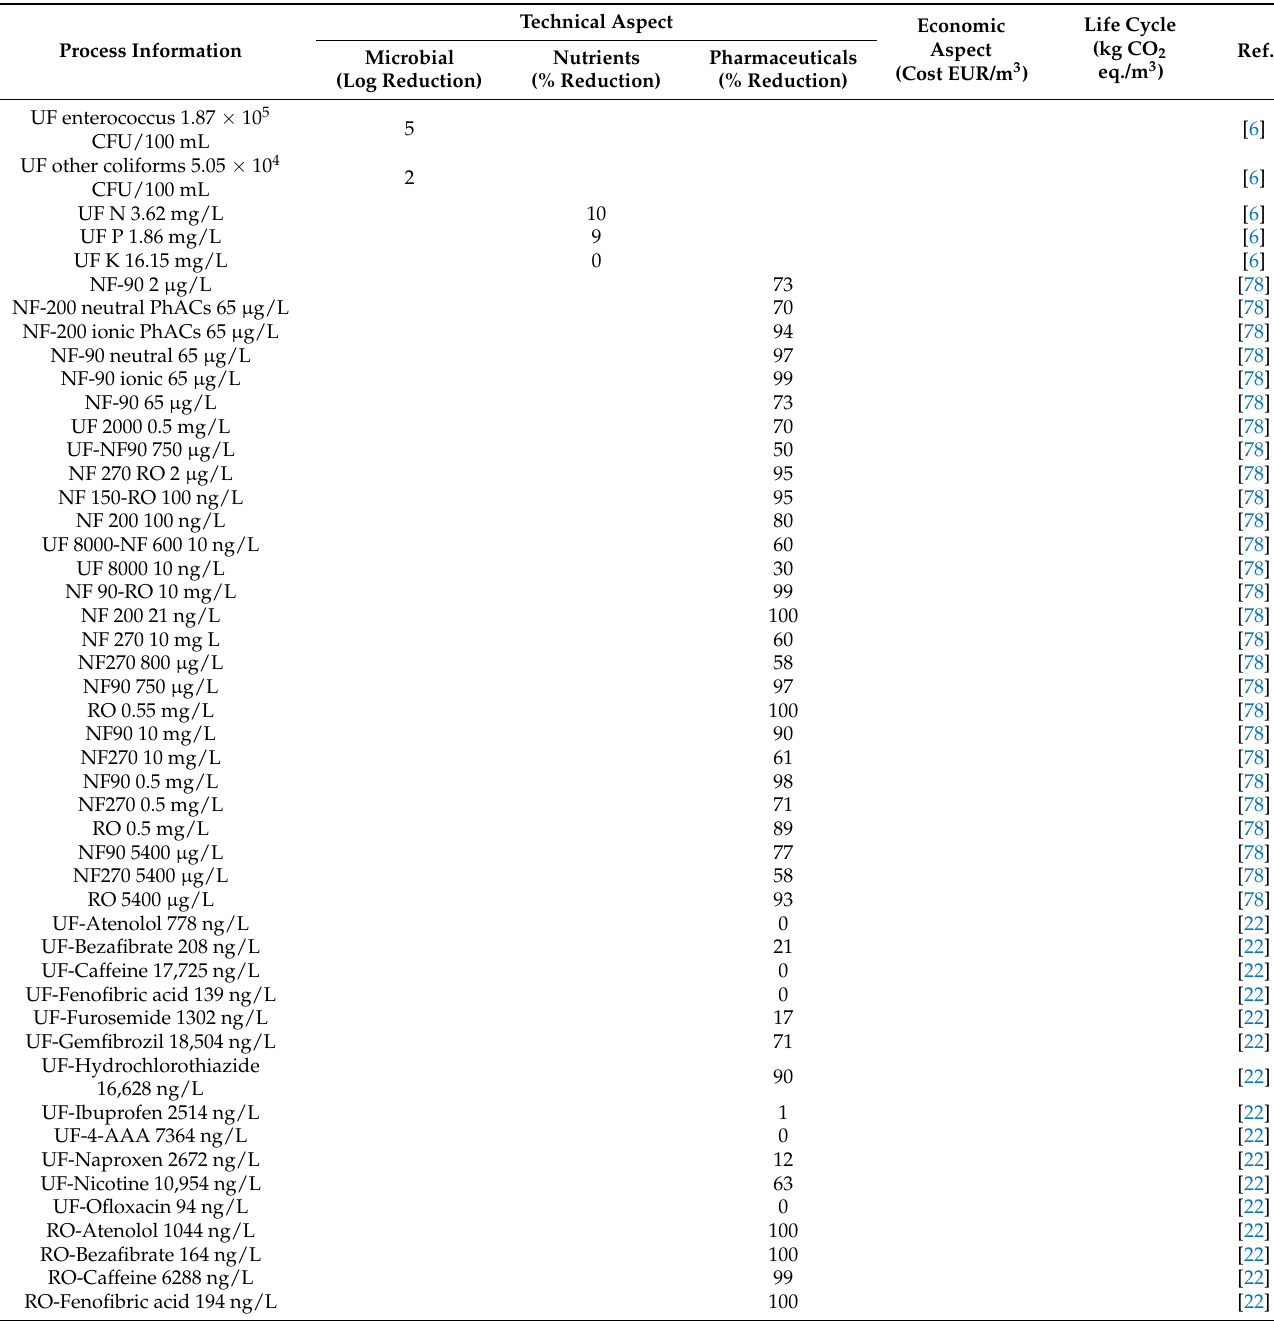
Table A3. Literature data used for scoring the membrane filtration